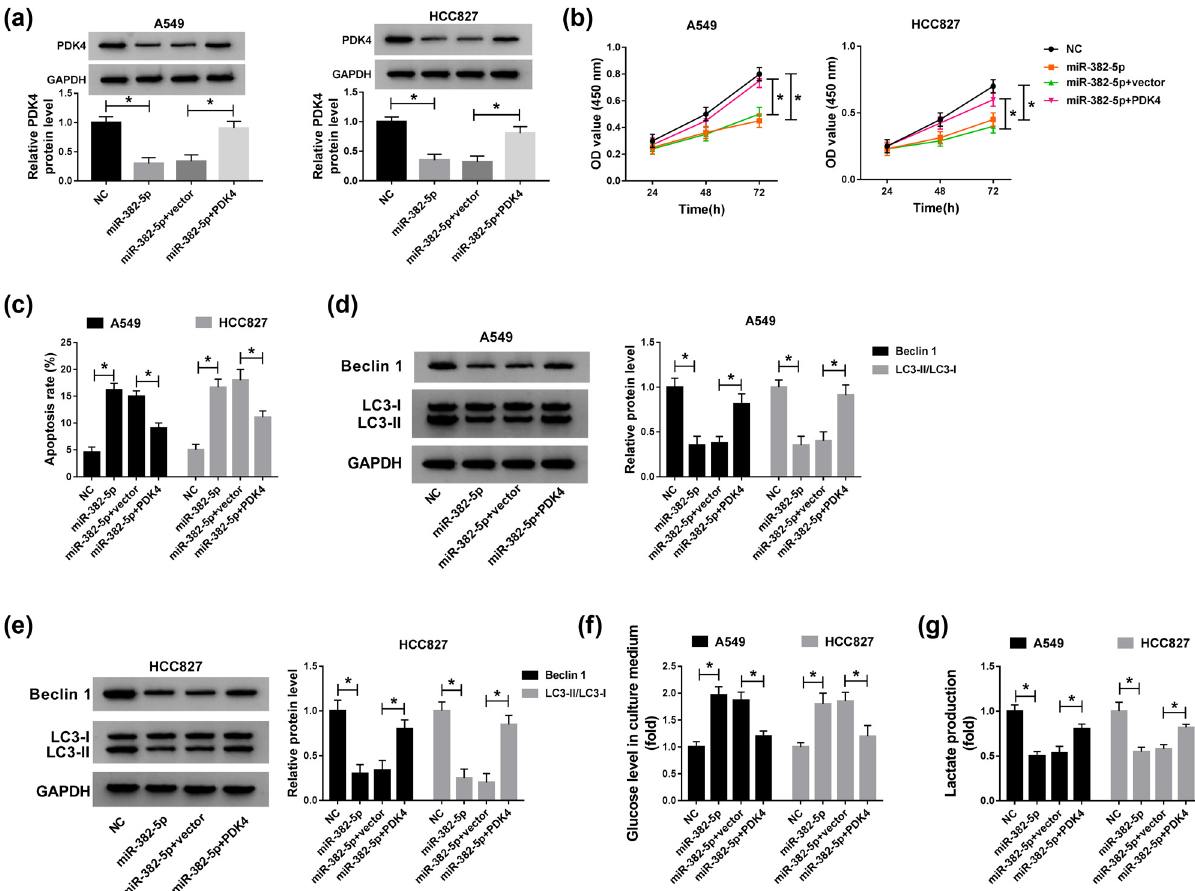
Figure 6: PDK4 overexpression abrogated the role of miR - 382 - 5p reintroduction. A549 and HCC827 cells were transfected with miR - 382 - 5p, NC, miR - 382 - 5p + PDK4, or miR - 382 - 5p + vector. ( a ) The transfection e ffi ciency was checked according to the expression level of PDK4 using western blot. ( b ) Cell proliferation was assessed by CCK - 8 assay. ( c ) Cell apoptosis was monitored by fl ow cytometry assay. ( d and e ) The protein levels of Beclin 1 and LC3 - II/LC3 - I were quanti fi ed by western blot. ( f and g ) The glycolysis progression was evaluated according to the level of glucose in culture medium and lactate production. * P <